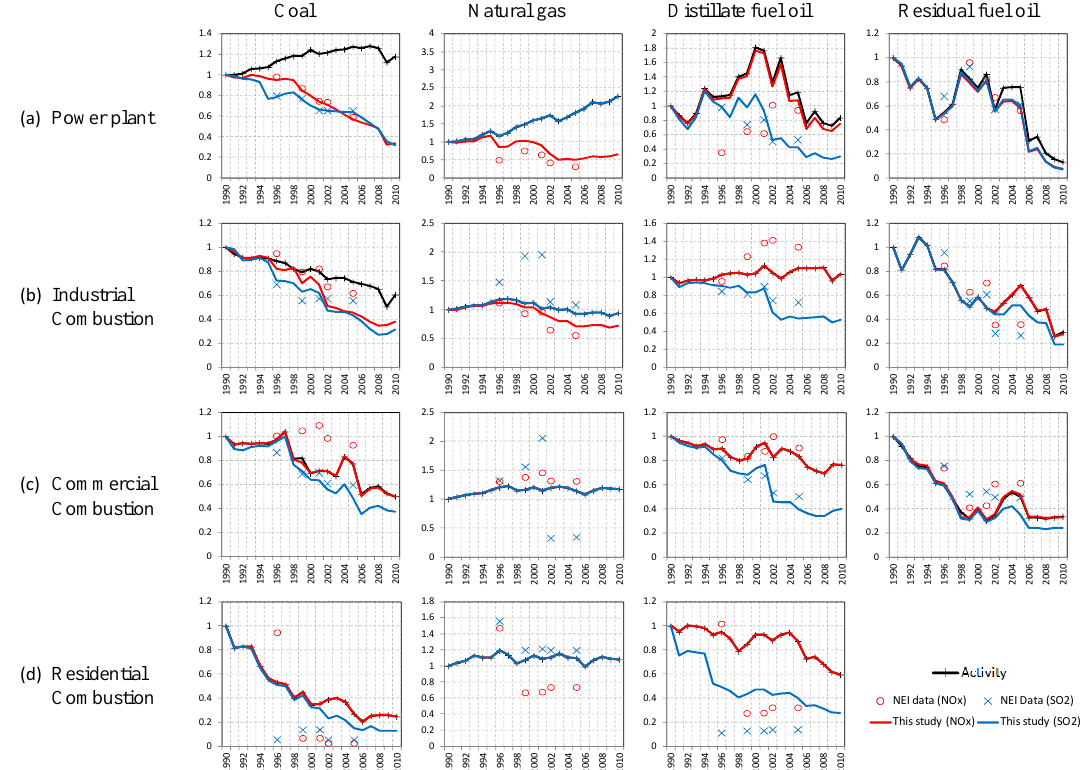
Fig. 3. Activity (fuel use) and NO x and SO 2 emission trends during 1990–2010 for energy-related stationary sources (year 1990 = 1; absolute values are provided in Table